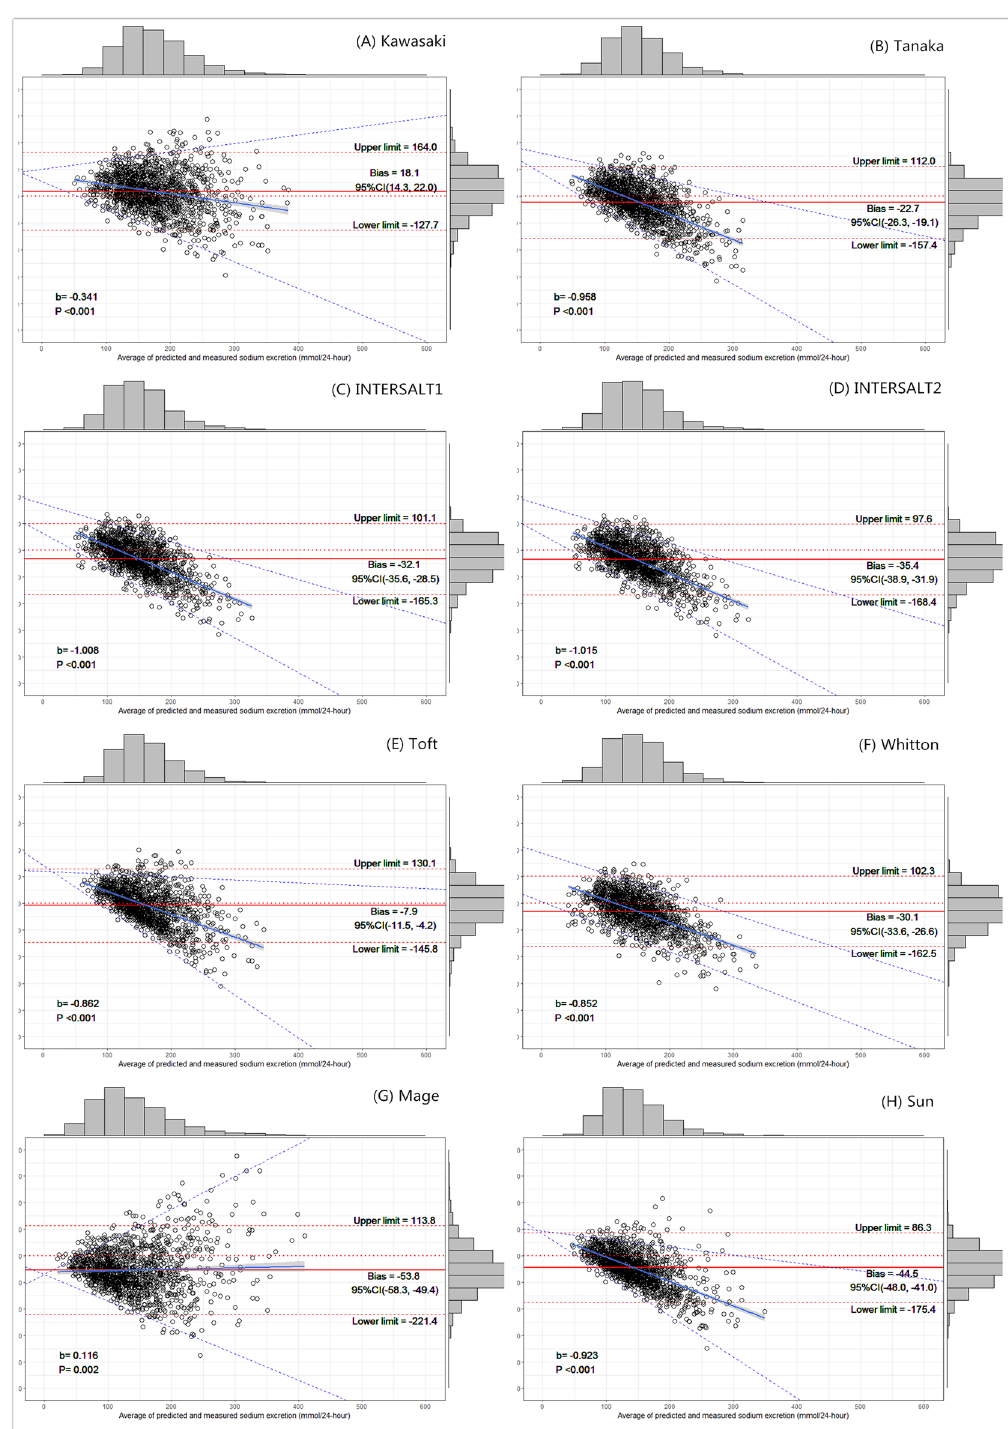
Figure 2. Bland–Altman plots of the estimated and measured 24-h urinary sodium excretion based on the Kawasaki Equation ( A ), Tanaka Equation ( B ), INTERSALT1 Equation ( C ), INTERSALT2 Equation ( D ), Toft Equation ( E ), Whitton Equation ( F ), Mage Equation ( G ), and Sun Equation ( H